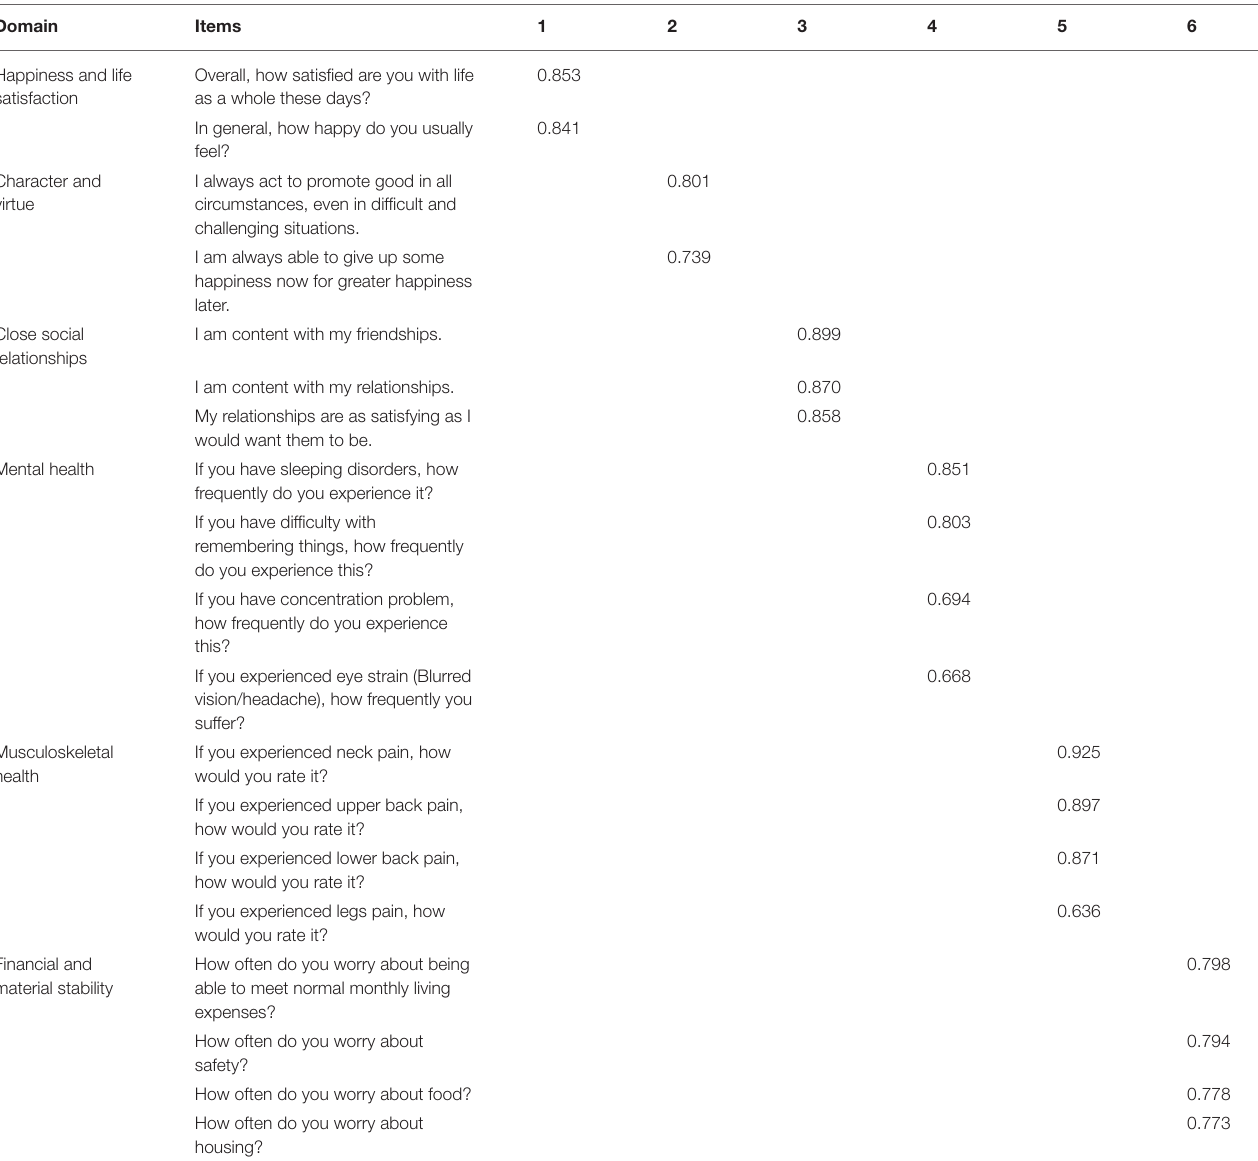
TABLE 2 | Factor loadings by EFA of Health and wellbeing.